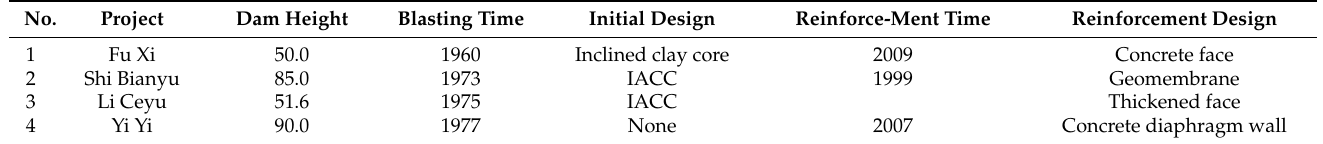
Table 2. The statistics on the reinforcement of blast-fill dams in